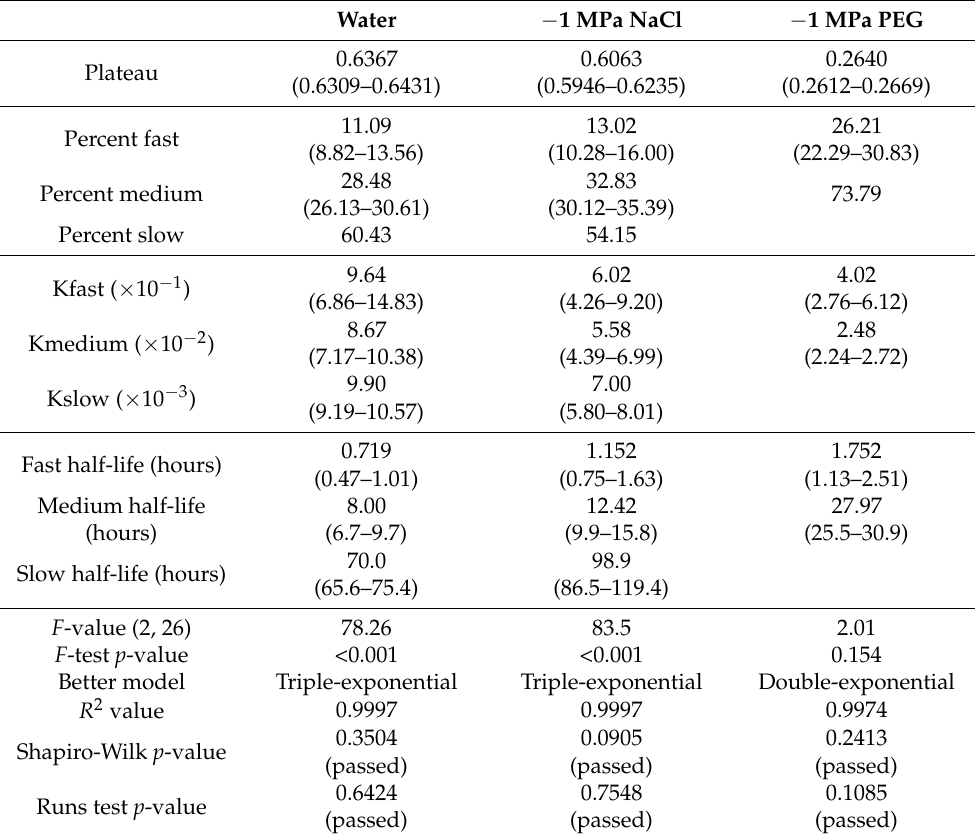
Table 2. Curve-fit parameters for water uptake time course data for seeds incubated in water, NaCl or PEG solutions in Figure 4. Numbers in parentheses represent the 95% confidence intervals of the estimates. An extra-sum-of-squares F-test was used to determine whether a more complex model fit the data significantly better than the immediately simpler